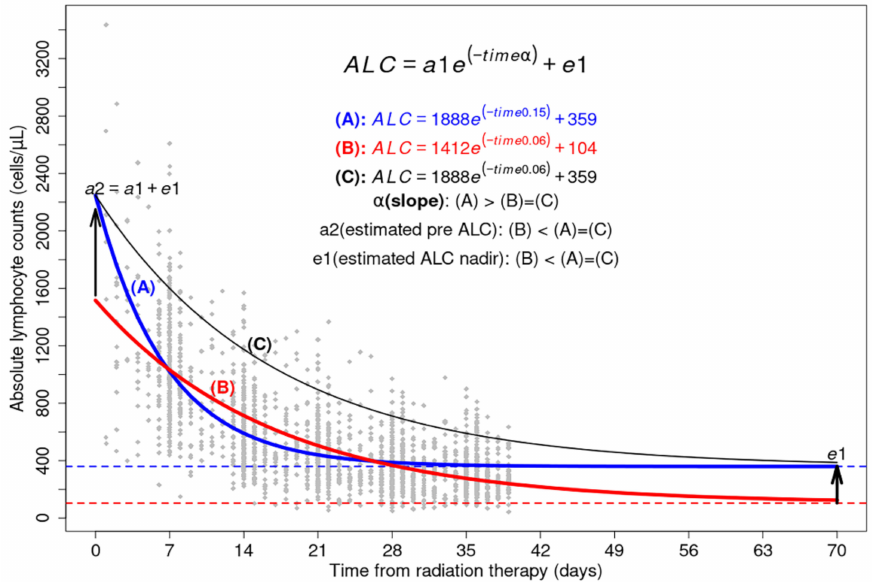
Figure 1. We plotted the 1927 absolute lymphocyte counts measured during radiation therapy from 323 patients (gray dots). Three estimated equations for exponential regression lines were calculated using two α , a 1, and e 1